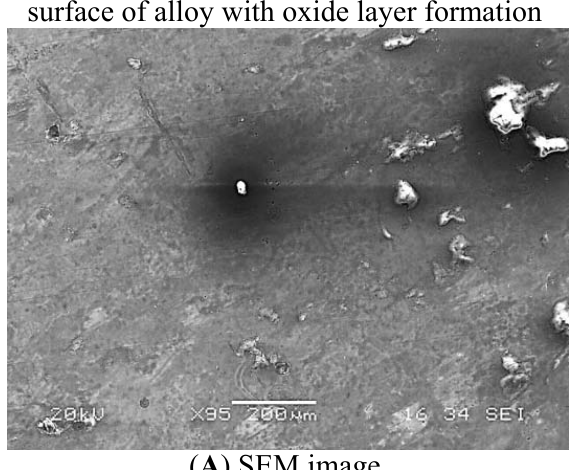
Figure 1. Scanning electron microscopy (SEM) images and X-ray photoelectron spectroscopy (XPS) analysis of oxide layer formation on the Mg-Zn-Se